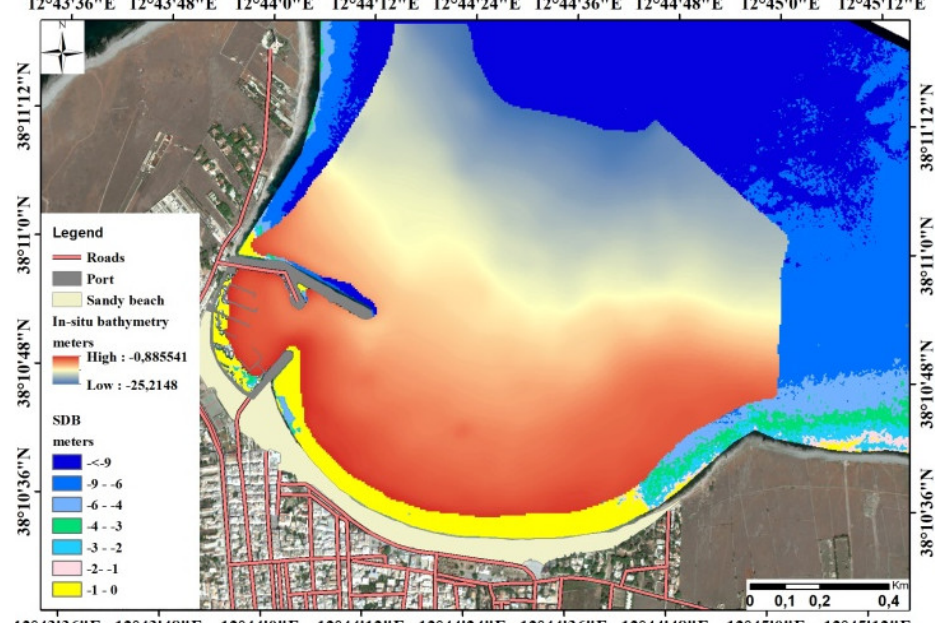
Figure 11. Spatial coverage comparison of SDB and SBES (single beam echo sounder) on the coast of San Vito Lo Capo.